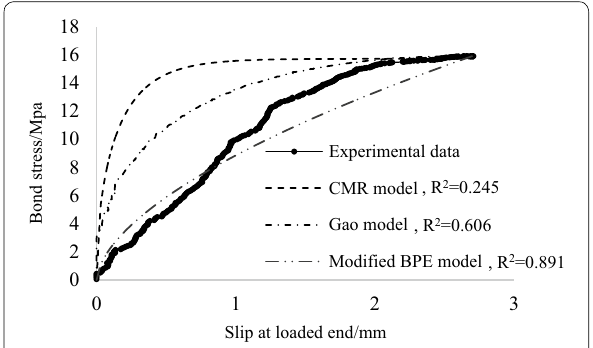
Fig. 12 Comparison of experimental data and existing